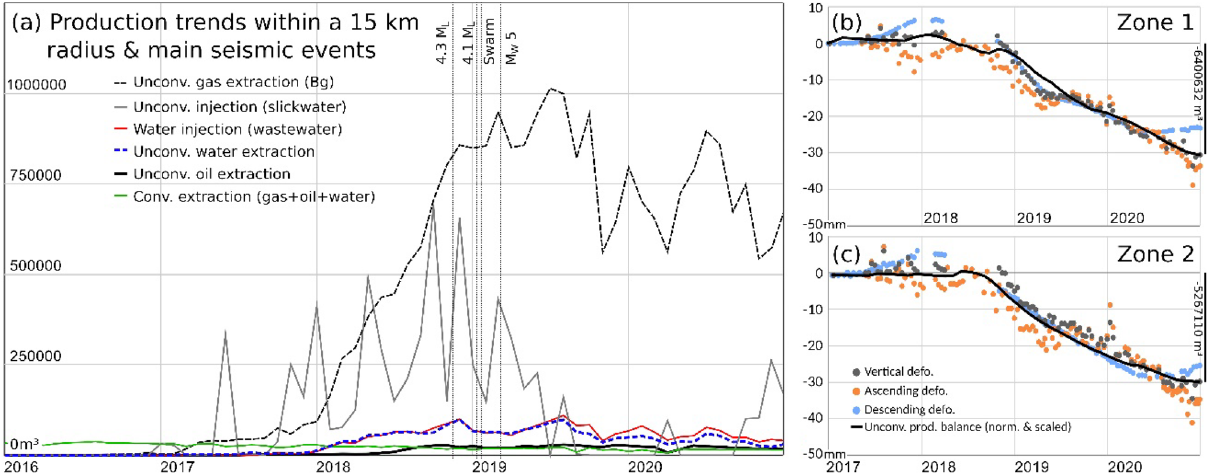
Figure 3. ( a ) Evolution of hydrocarbon production (in m 3 ) between 2016 and 2020 in the area bounded by the red dashed circle in Fig. 1a. The vertical dashed lines show the main seismic events. Panels ( b ) and ( c ) show the time series of ground deformation for zones 1 and 2, respectively, during the period 2017–2020 and the monthly accumulated unconventional production balance (black line) normalised and inversely scaled. The vertical scale bar in the right axis of figures ( b ) and ( c ) provide information on the total accumulated volumetric amount (m 3 ) of unconventional fluid